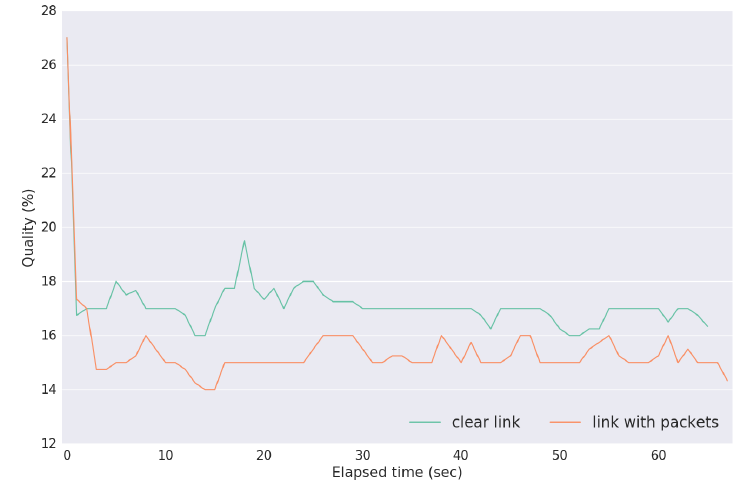
Figure 17. Quality values given by Equation (2), for an unused link (node 4 to node 3) and a link with packets (node 2 to node 3) in Scenario B, test